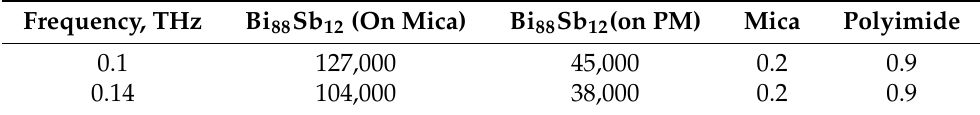
Table 2. Relative permittivity, imaginary part.